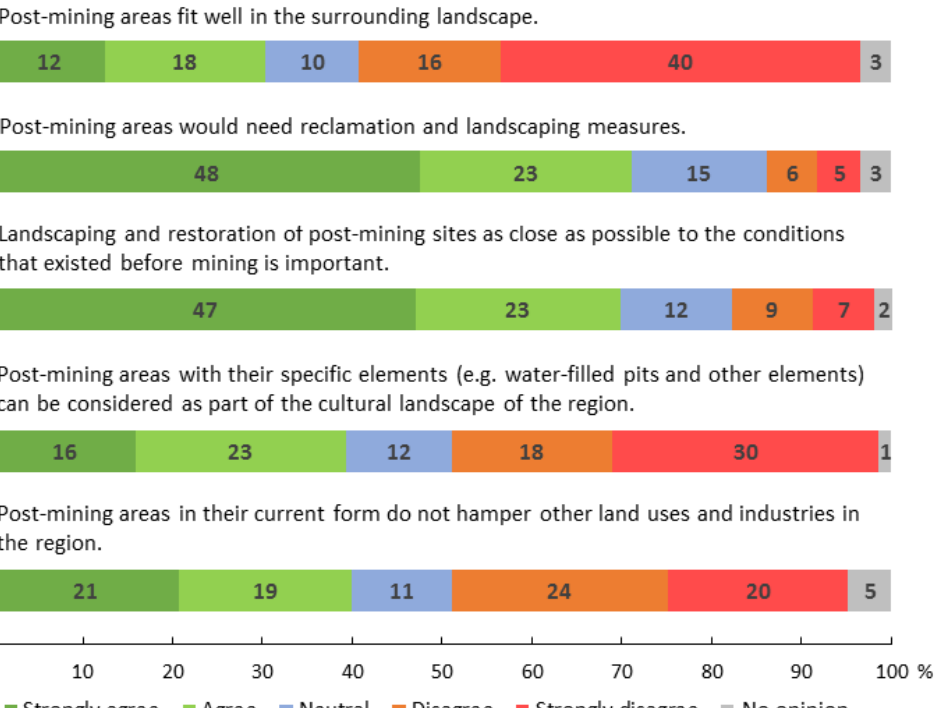
Figure 3. Characteristics of respondents (n = 145) participating in the public participation geographic information system (PPGIS) survey according to their relation to the region: local residents living <20 km distance (n = 46) and >20 km distance (n = 34) from the mining sites, vacation home owners <20 km distance (n = 29) and >20 km distance (n = 11) from the mining sites, and visitors (n = 25). ( A ) gender, ( B ) age, ( C ) respondent works in the mining industry, and ( D ) respondent’s relative(s) work in the mining industry.